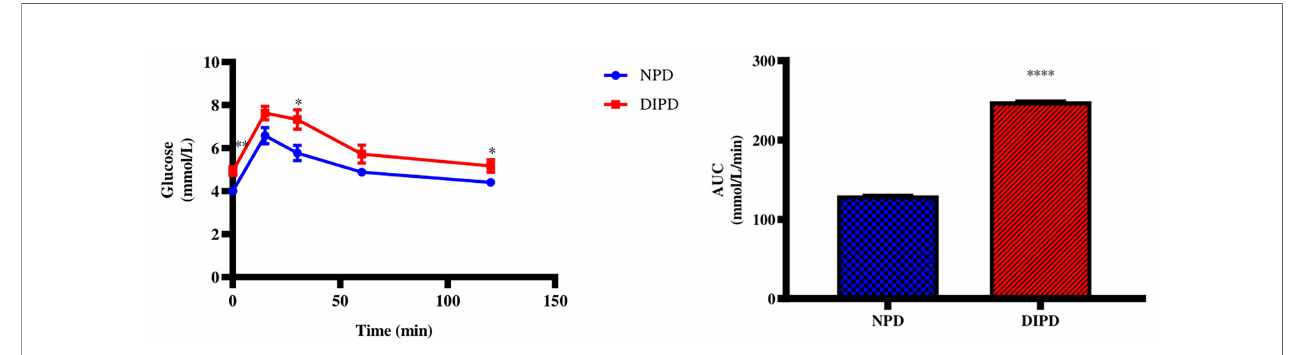
FIGURE 1 | The OGT response and AUC values in the non-pre-diabetic (NPD) group and diet-induced pre-diabetic group (DIPD) (n=6, per group). Values are presented as mean ± SEM. *=p < 0.05, **=p < 0.01, ****= p < 0.0001 by comparison with